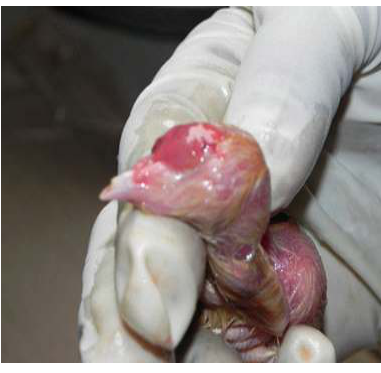
Figure-1. Photograph showing short upper beak